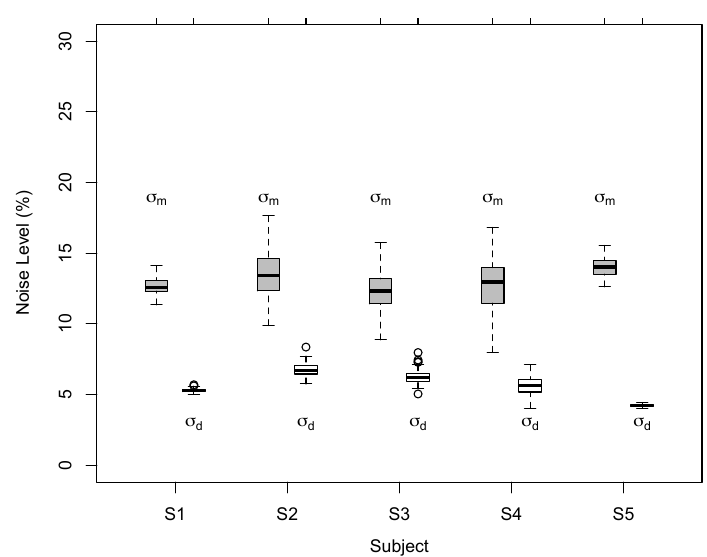
Figure 10. Individual noise estimates for BVN2 in Exp. 2. Estimates of monocular motion ( σ m ) and dynamic depth ( σ d ) for Observer S1 to S5 for bootstrapped data. Thick horizontal lines denote medians, boxes the second and third quartile with error bars (whiskers) extending 1.5 times of the interquartile range. Open circles denote outliers. All pairwise differences between individual motion and depth noise estimates were statistically significant ( p < 0.0002, two-tailed t -test,